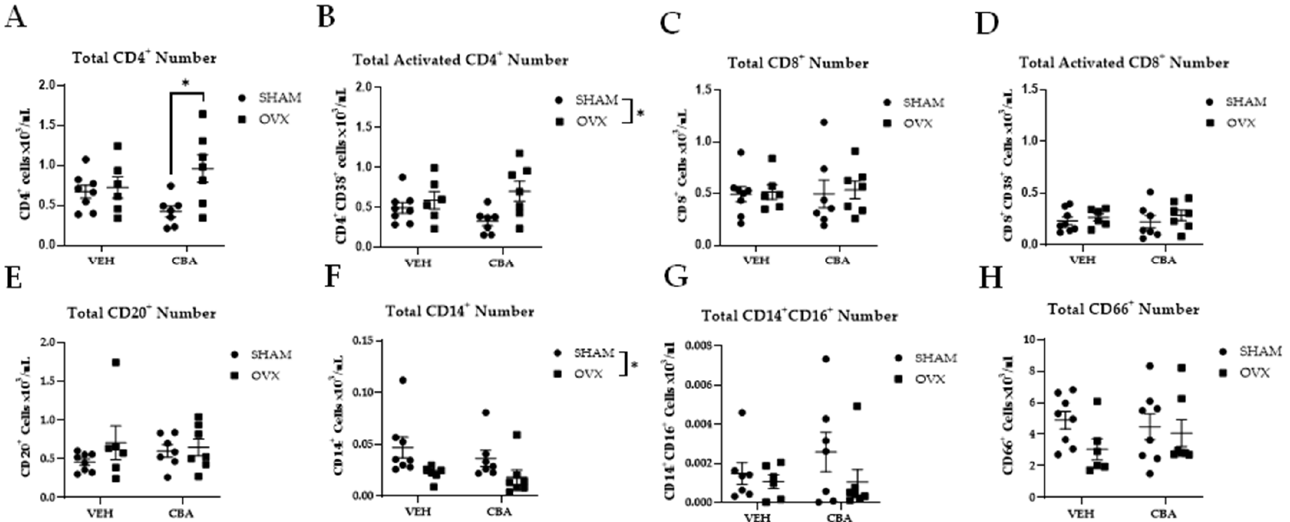
Figure 3. Immune cell distribution. ( A ) CBA/OVX had significantly higher CD4 + T cells compared to CBA/SHAM. ( B ) There was a main effect of OVX to increase activated CD4 + (CD38 + ) T cell num ‐ bers (asterisk represents the main effect of OVX). ( C ) There were no statistically significant differ ‐